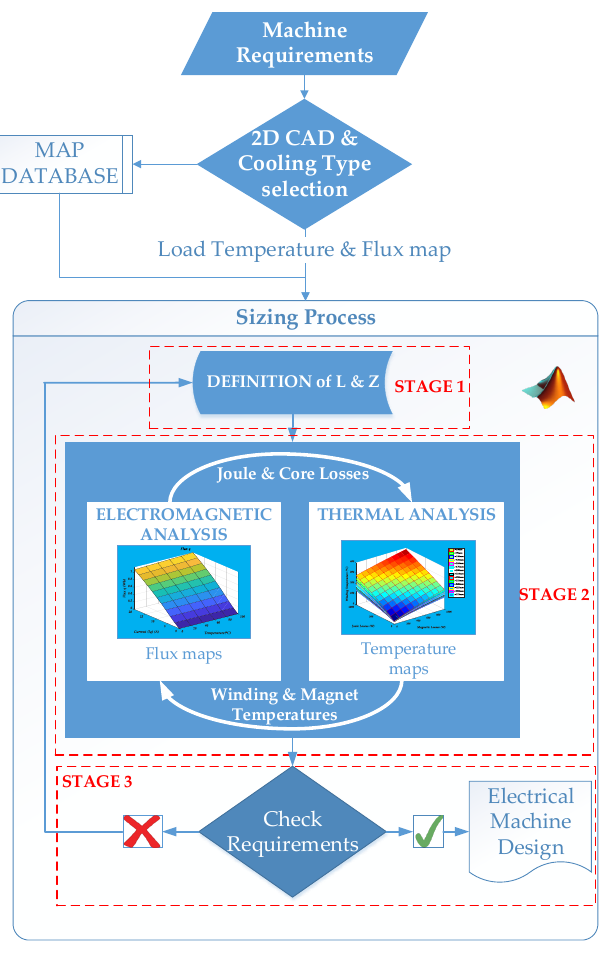
Figure 6. Sizing